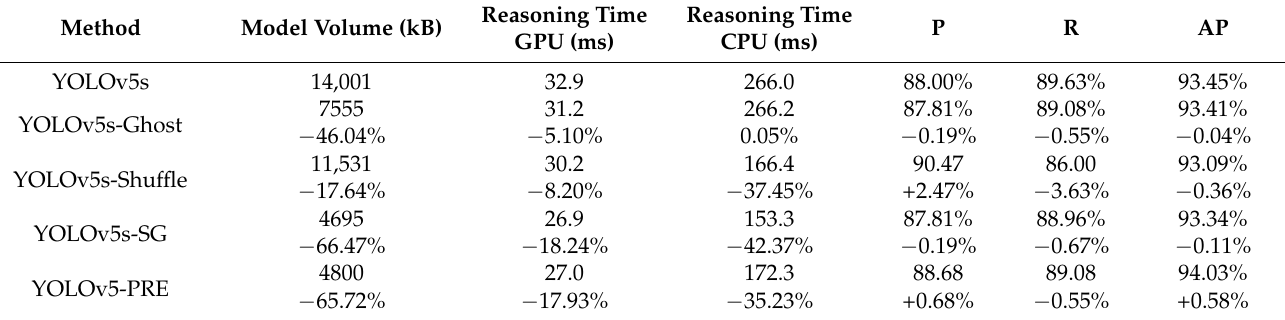
Table 4. Table 4. Comparison of algorithm Table 4. Comparison of algorithm performance.